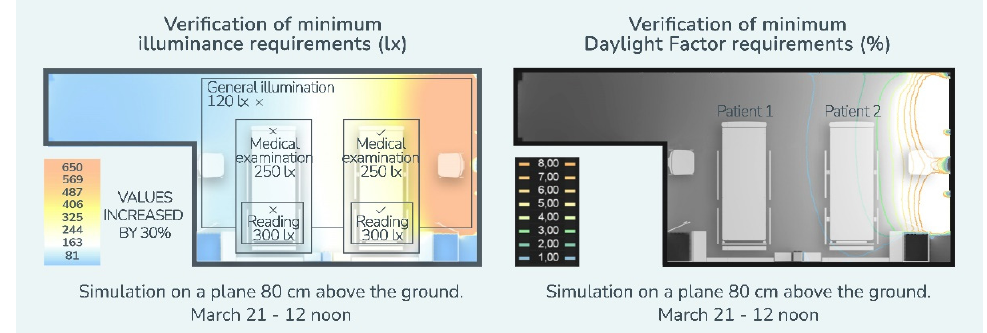
Figure 14. Room 2. Verification of minimum illuminance (lx) and daylight factor (%) requirements on ante operam.